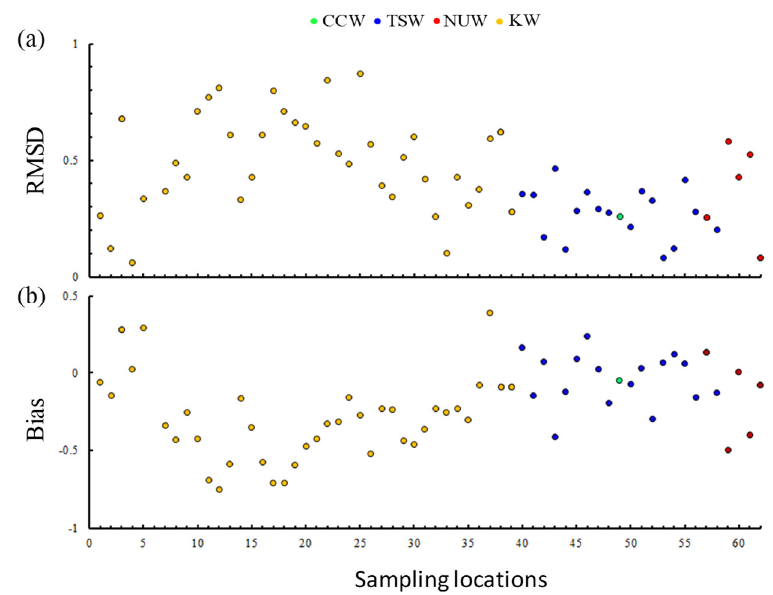
Figure 7. ( a ) RMSD and ( b ) bias for the 62 sampling locations in the four subareas of the CCW (green circles), TSW (blue circles), NUW (red circles), and KW (yellow circles).